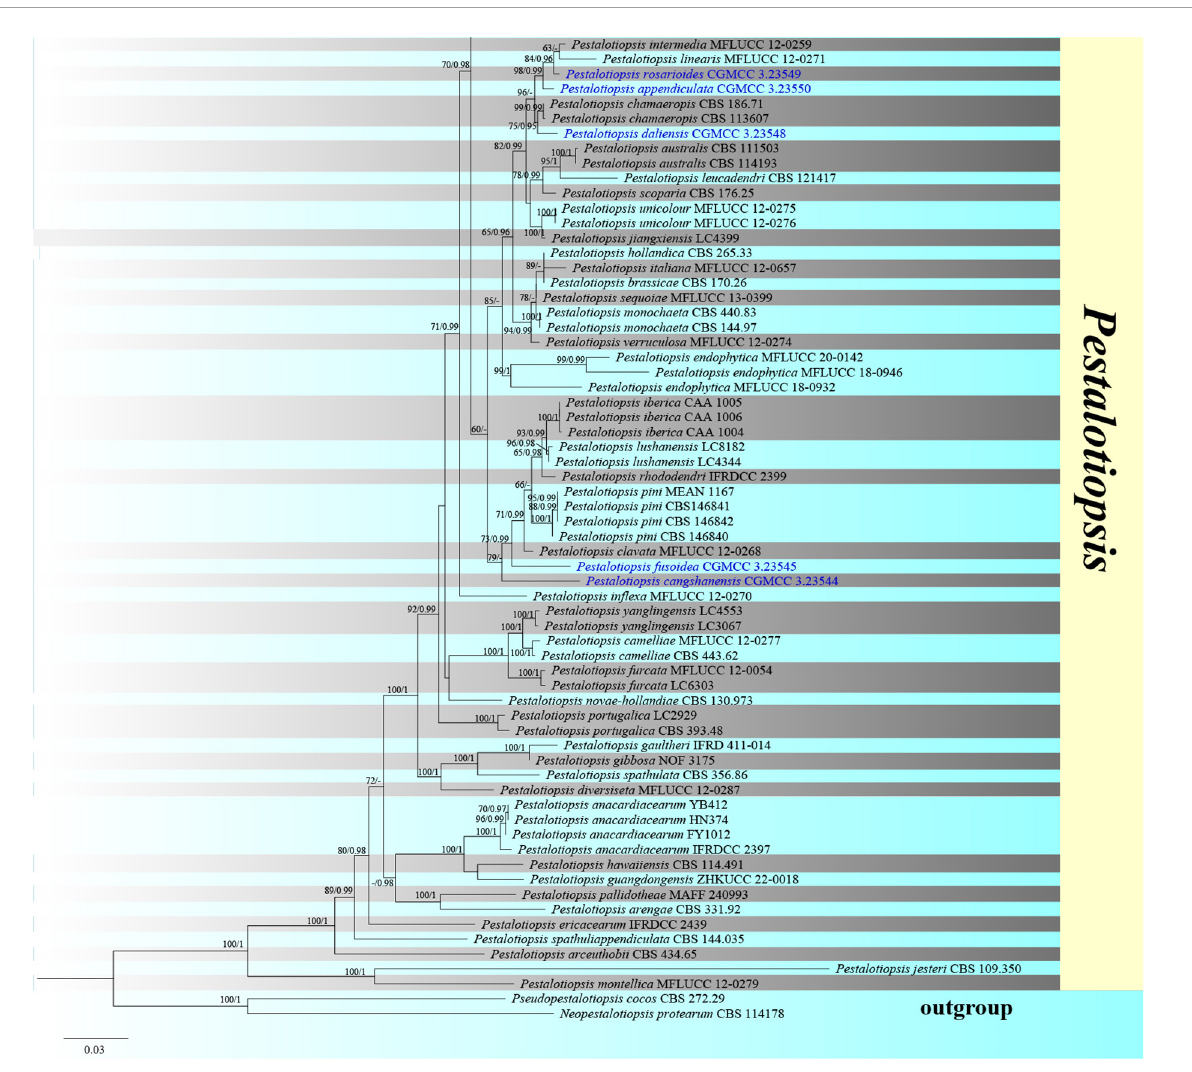
FIGURE1 Phylogenetic tree based on RAxML analyses of a combined internal transcribed spacer (ITS), translation elongation factor 1-alpha (TEF1- α ), and β -tubulin (TUB) dataset. Bootstrap support values for maximum likelihood ≥ 60% and Bayesian posterior probabilities ≥ 0.95 are indicated above the nodes as Maximum likelihood/Posterior probabilitie (ML/PP). The tree is rooted in Neopestalotiopsis protearum (CBS 114.178) and Pseudopestalotiopsis cocos (CBS 272.29). The new isolates are in